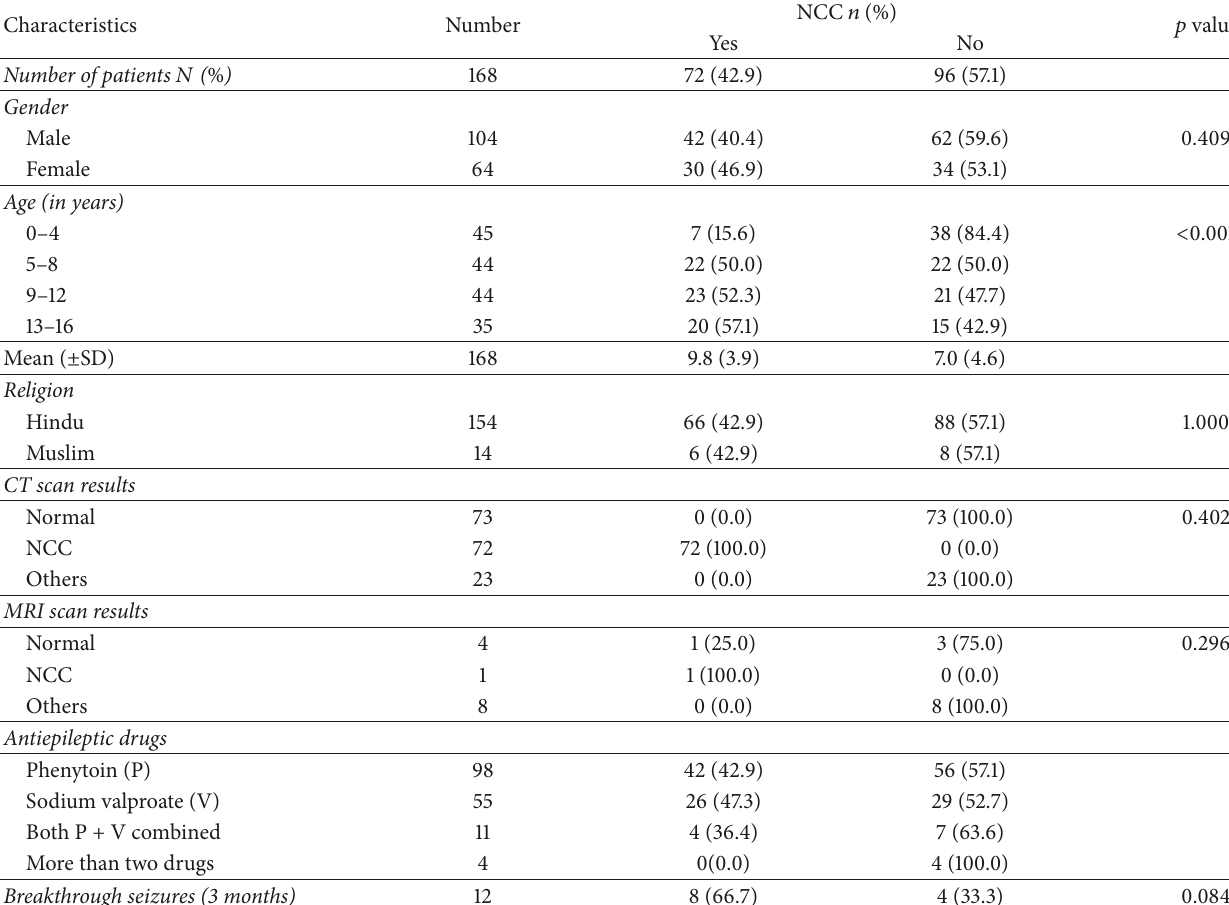
Table 1: Sociodemographic characteristics, neuroimaging, and antiepileptic drug use in children with NCC. Characteristics